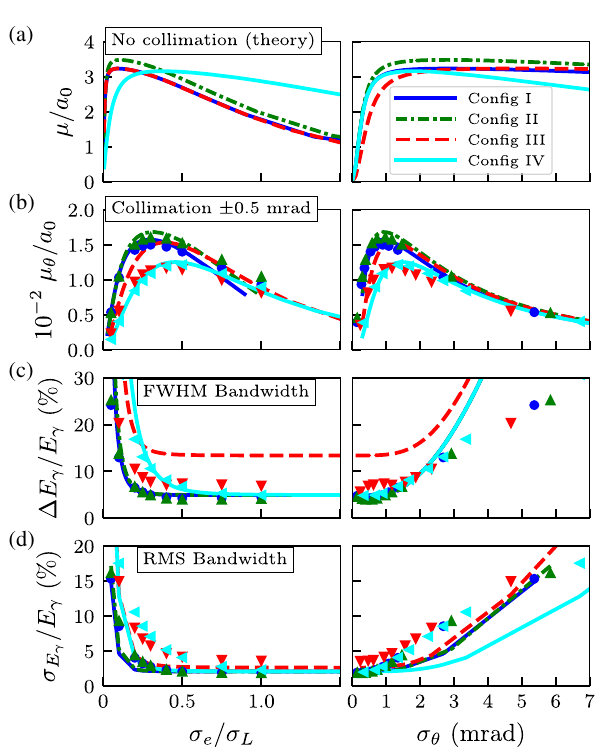
FIG. 4. Photon production μ , cone photon production μ θ and collimated bandwidth dependence on electron-laser waist ratio σ = σ σ e L and electron bunch divergence θ . Bunch waist and divergence are related via Eq. (A1). For various laser parameters (legend), the photon production μ in the full synchrotron angle (a) and μ θ within the collimation angle θ ¼ (cid:2) 0 . 5 mrad (b) are displayed. The collimated bandwidth BW θ for the FWHM theory along Ref. [66] and the RMS theory along Ref. [75] are shown in (c) and (d), respectively. Theoretical results are represented by lines, simulations as markers. The parameters for the different configurations are found in